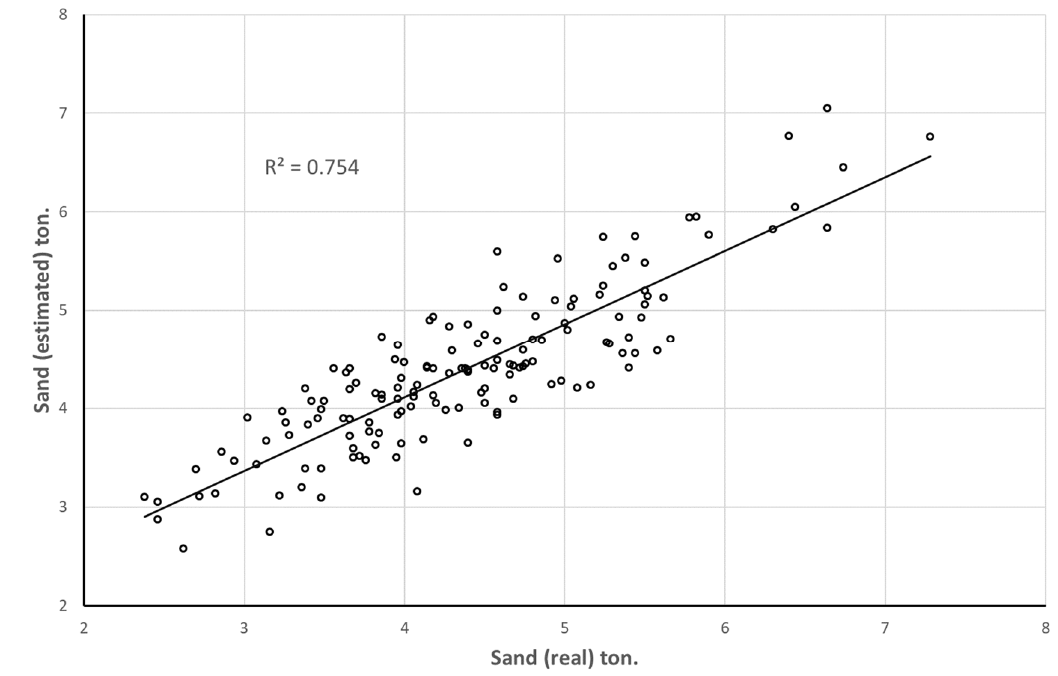
Figure 3. Prediction performance of the Multivariate Adaptive Regression Splines (MARS) model (training data).